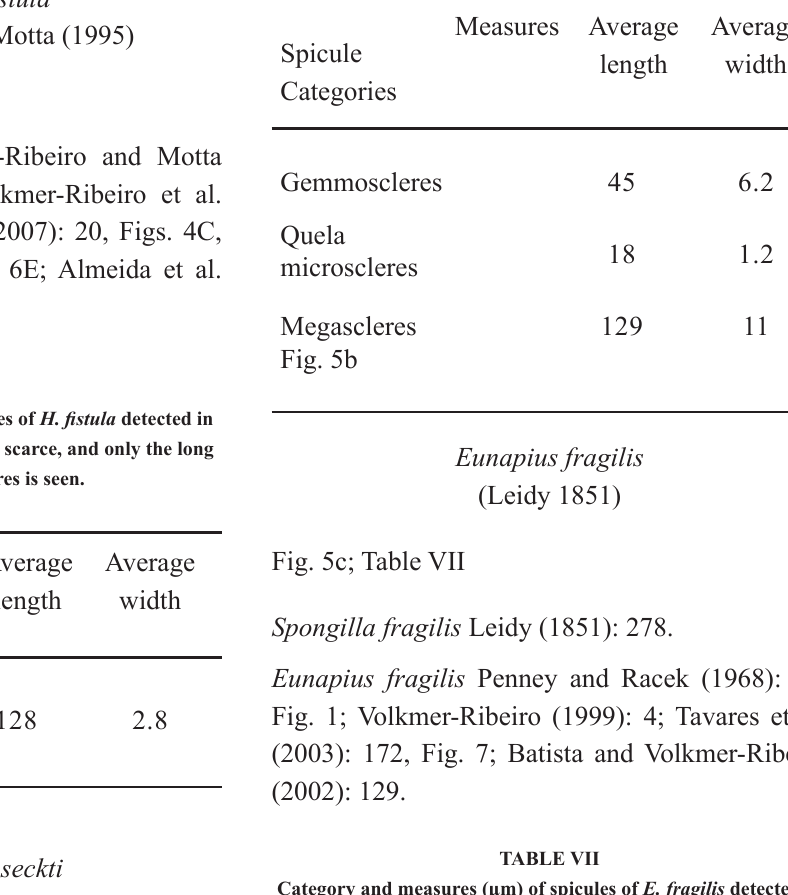
Category and measures (µm) of spicules of E. fragilis detected in the studied sections. Spicules are scarce.